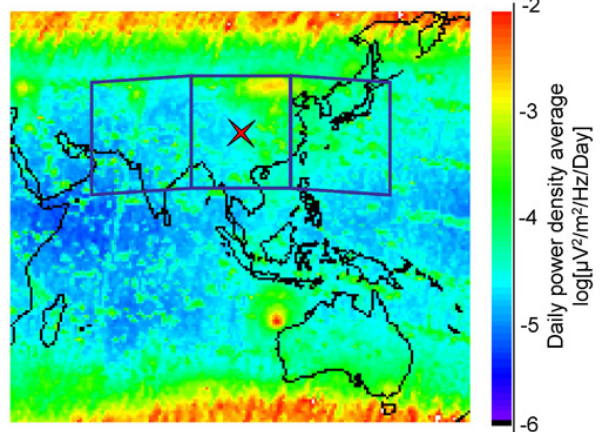
Fig. 5. Map of the total power of whistler emissions averaged over 6-yr all-year data. The epicentre of Sichuan earthquake is marked with a red cross.